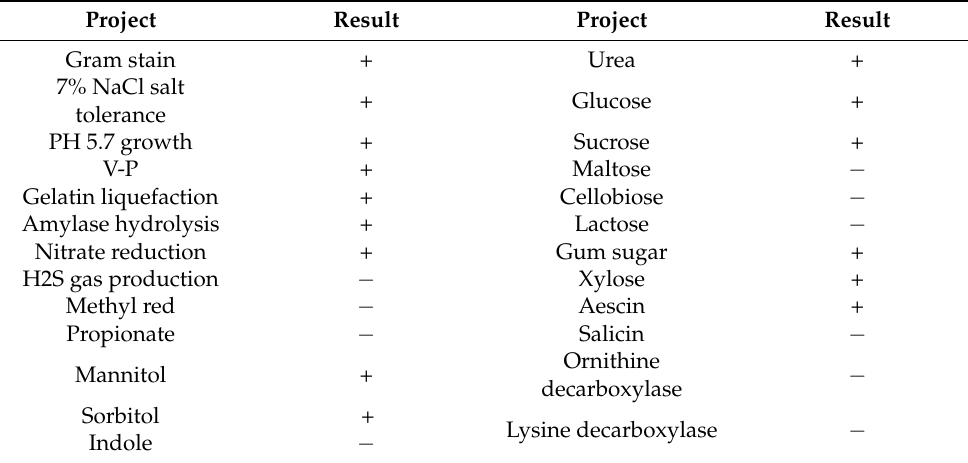
Table 1. Physiological and biochemical characteristics of strain Z-1.